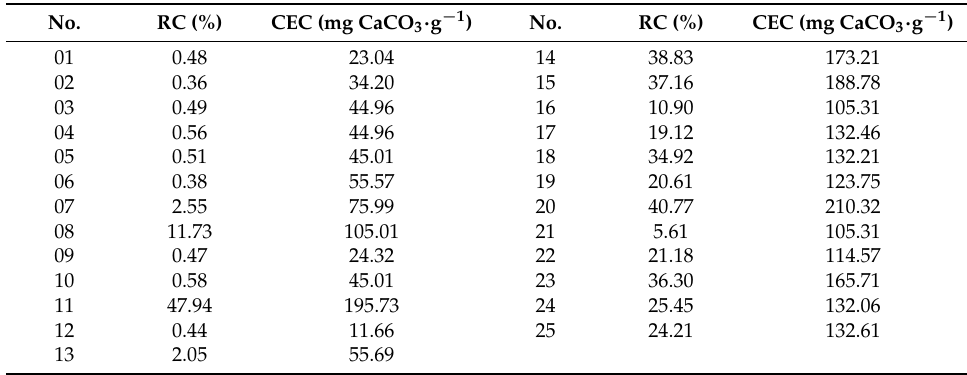
Table 3. Relative crystallinity (RC) and cation exchange capacity (CEC) of synthesized samples. No.